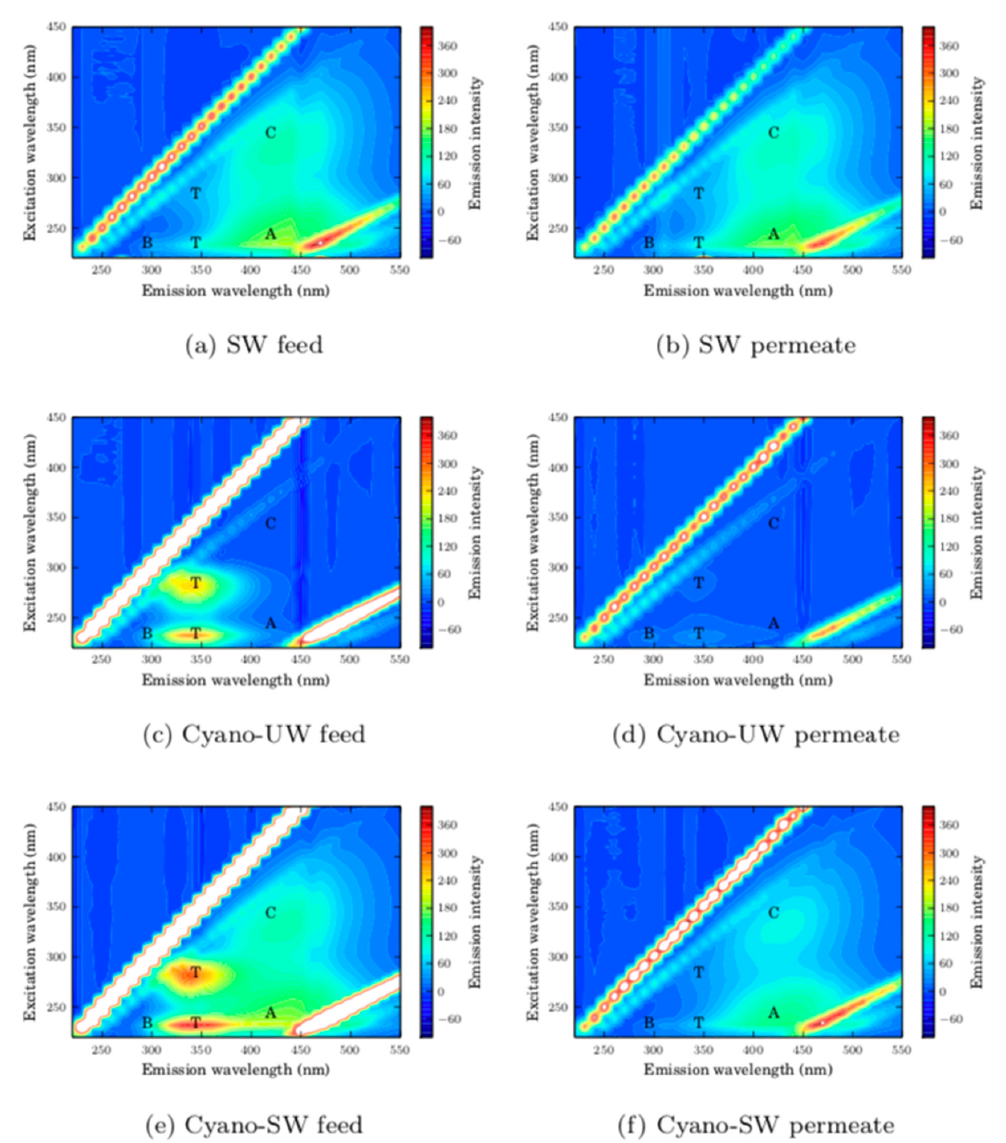
Figure 4. Fluorescence excitation-emission matrices of membrane feed and permeate streams. The peaks A (excitation / emission: 237-260 / 400-500 nm) and C (excitation / emission: 300-370 / 400-500 nm) represent the humic-like and fulvic-like substances. The B (excitation / emission: 225-237 / 309-321 and 275 / 310 nm) and T (excitation / emission: 225-237 / 340-381 and 275 / 340 nm) peaks represent the tyrosine protein-like and the tryptophan protein-like substances [21].